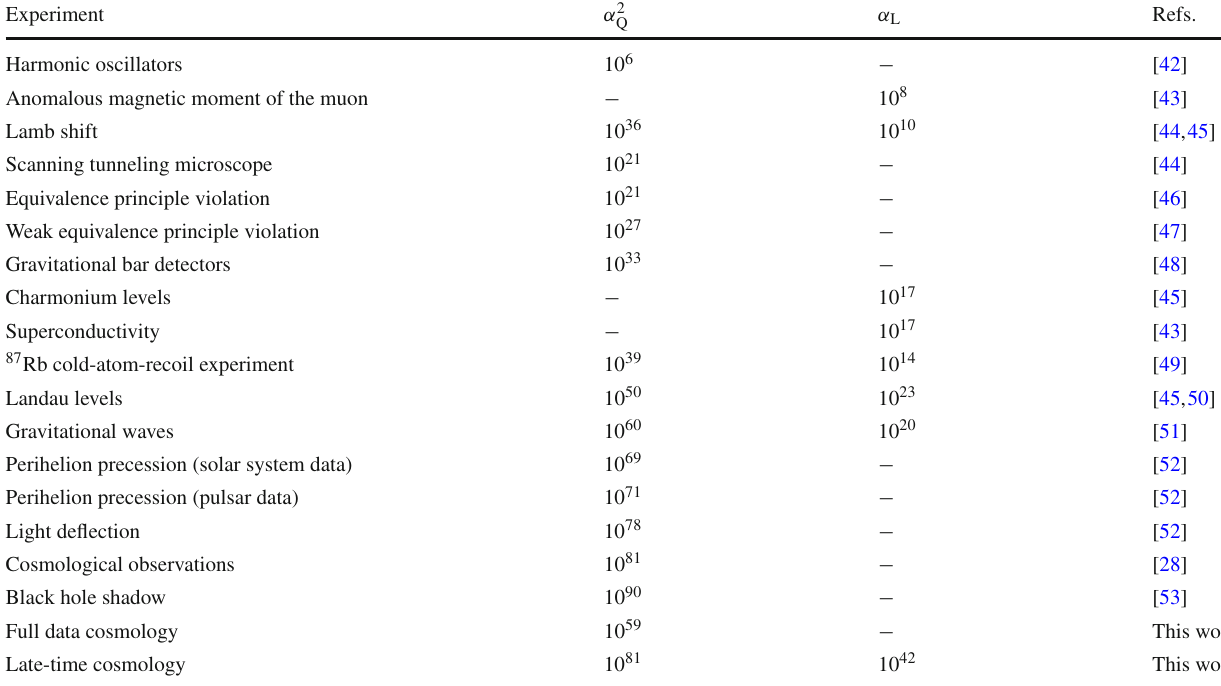
and α L at 1 σ confidence level Q